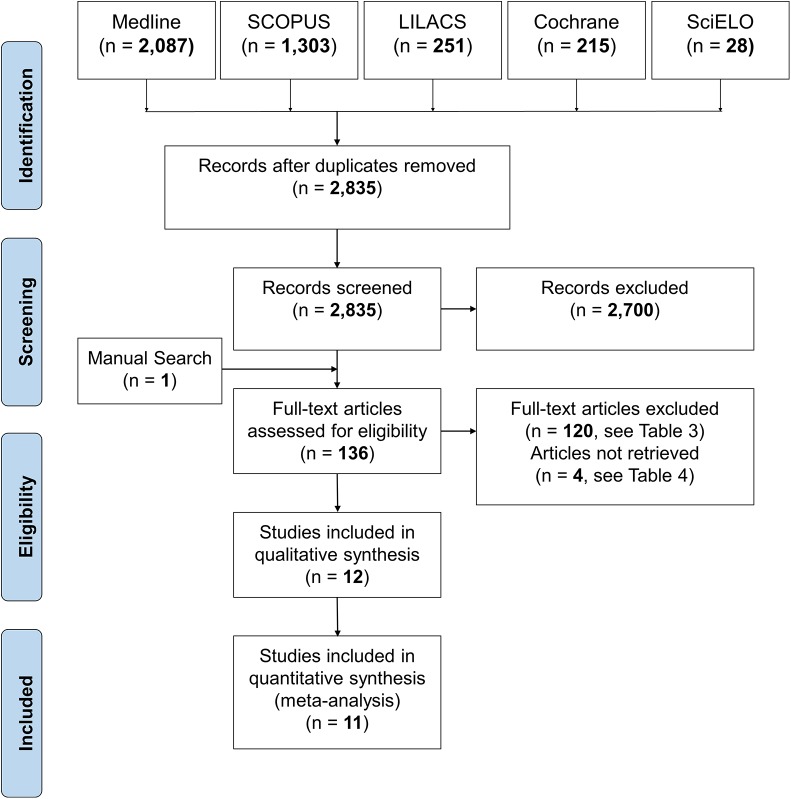
Flow diagram of the search strategy.